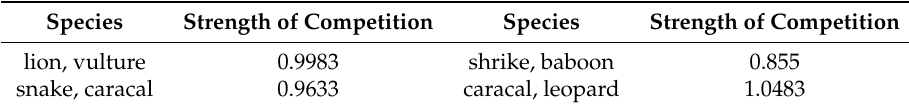
Table 4. Strength of competition between